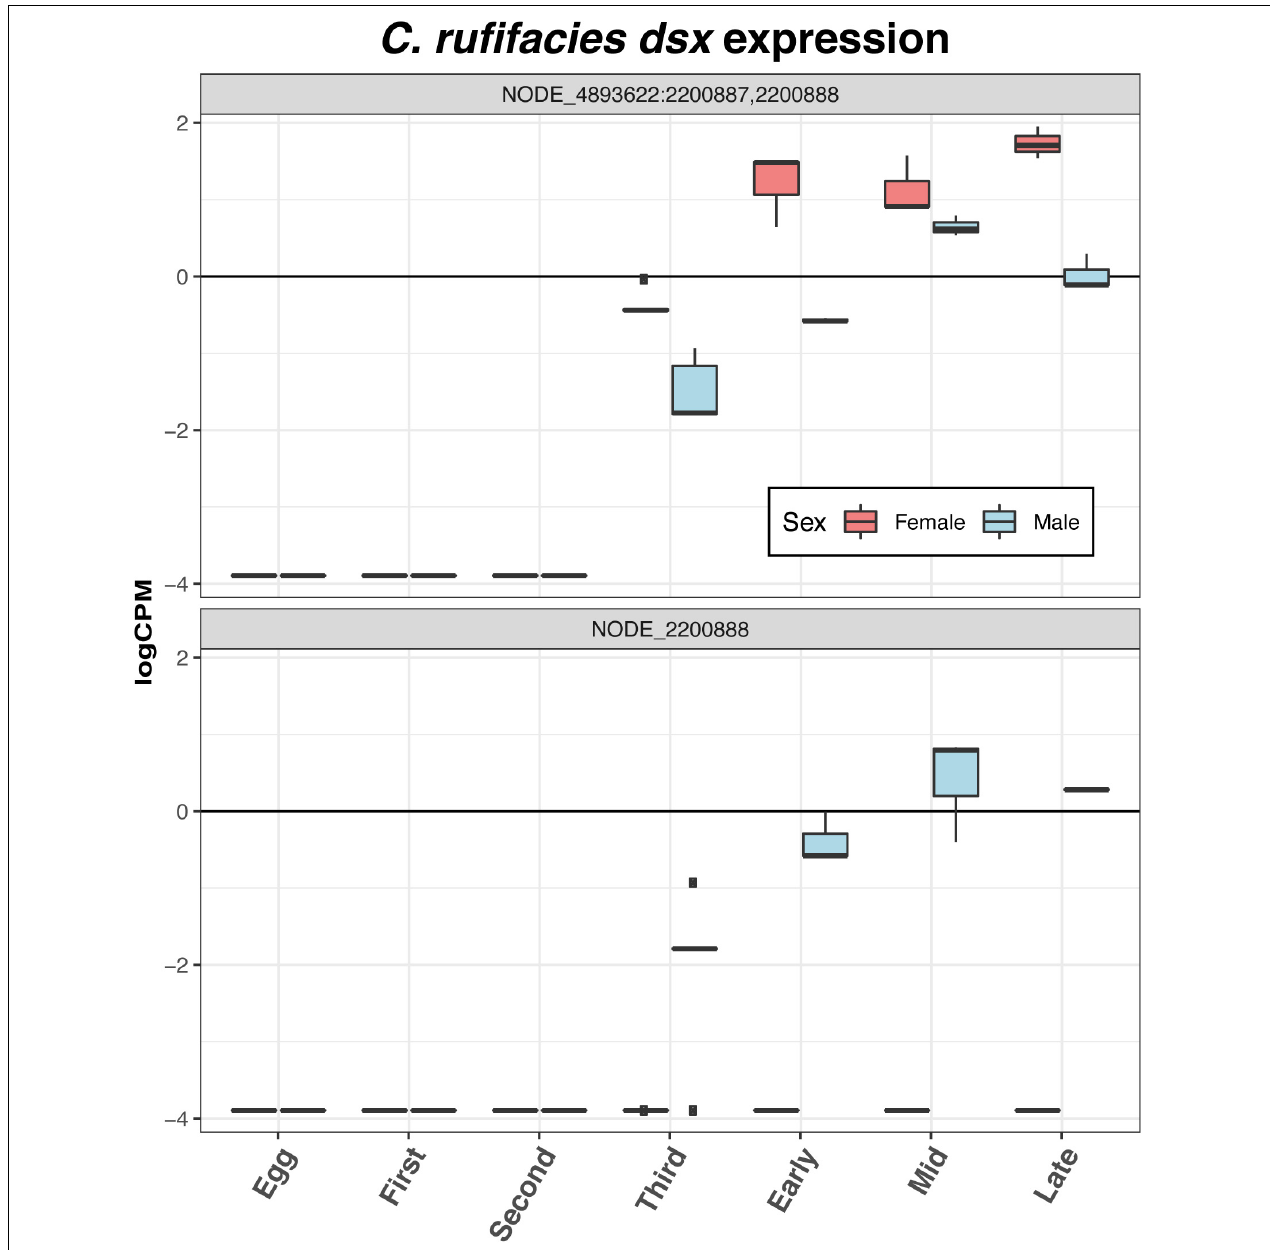
FIGURE 5 | Both nodes with homology to D. melanogaster dsx that passed the filtering cutoffs demonstrate sexual dimorphism in expression. In both sexes, expression is initiated in the third instar, though one node is only expressed only in males.